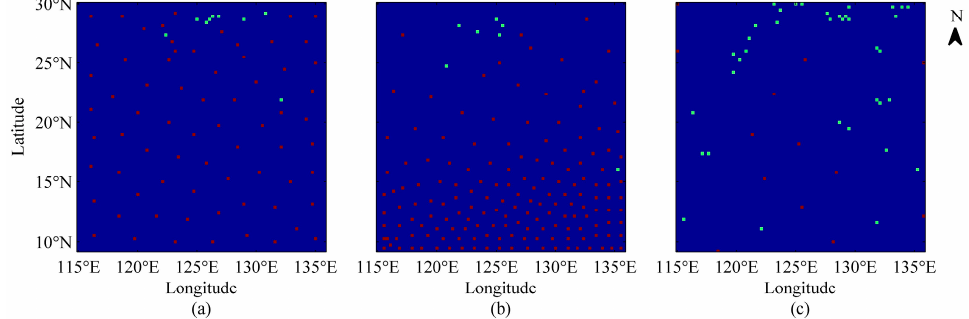
Figure 5. The distributions of hidden knots for radial basis function network (RBFN) on 13 June 2014 from ( a ) K-means algorithm; ( b ) Kohonen-map algorithm and ( c ) improved nearest neighbor cluster (INNC) algorithm respectively. The red points and green points are the locations of hidden knots for RBFNs separately selected from the background field and the SST samples.